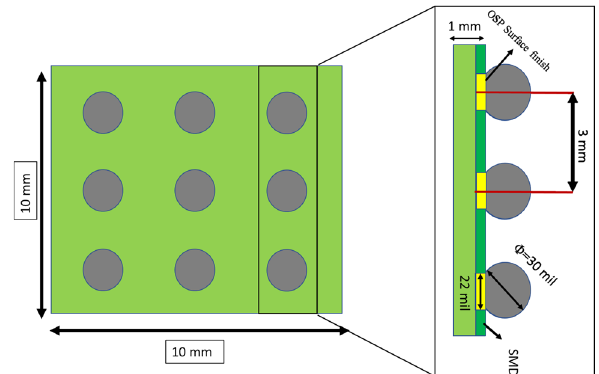
Figure 1. The test vehicle.